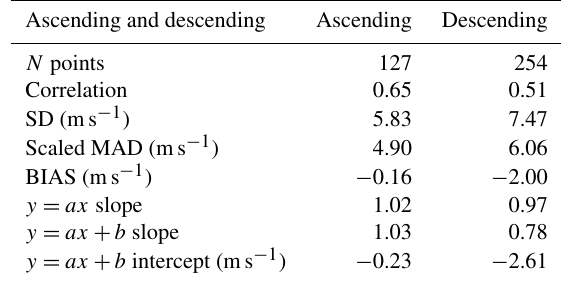
Table 6. Statistical comparison of Aeolus Rayleigh ascending and descending HLOS winds and CDL-retrieved HLOS